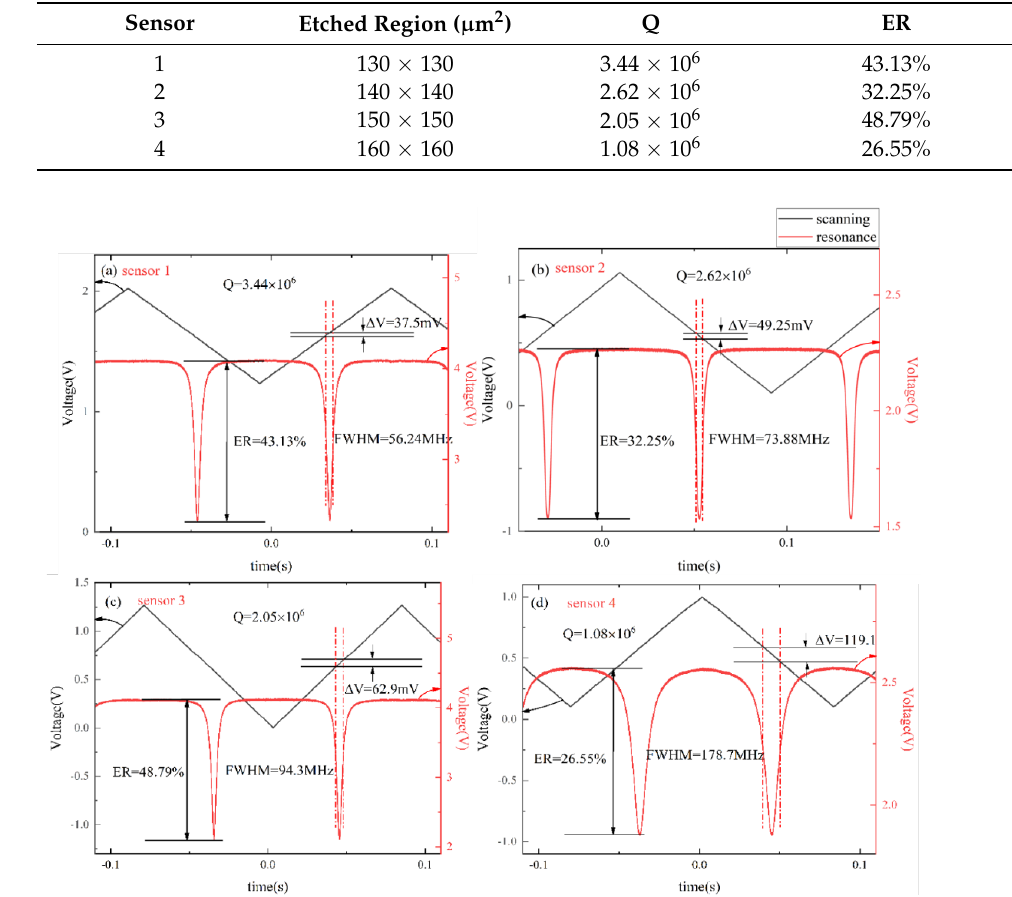
Figure 3. The FWHM and ER property of ring resonators: ( a ) Q = 3.44 × 10 6 with the groove of 130 × 130 µm 2 ; ( b ) Q = 2.62 × 10 6 with the groove of 140 × 140 µm 2 ; ( c ) Q = 2.05 × 10 6 with the groove of 150 × 150 µm 2 ; ( d ) Q = 1.08 × 10 6 with the groove of 160 × 160 µm 2 . Table 1. The parameters of the manufactured ring resonators.